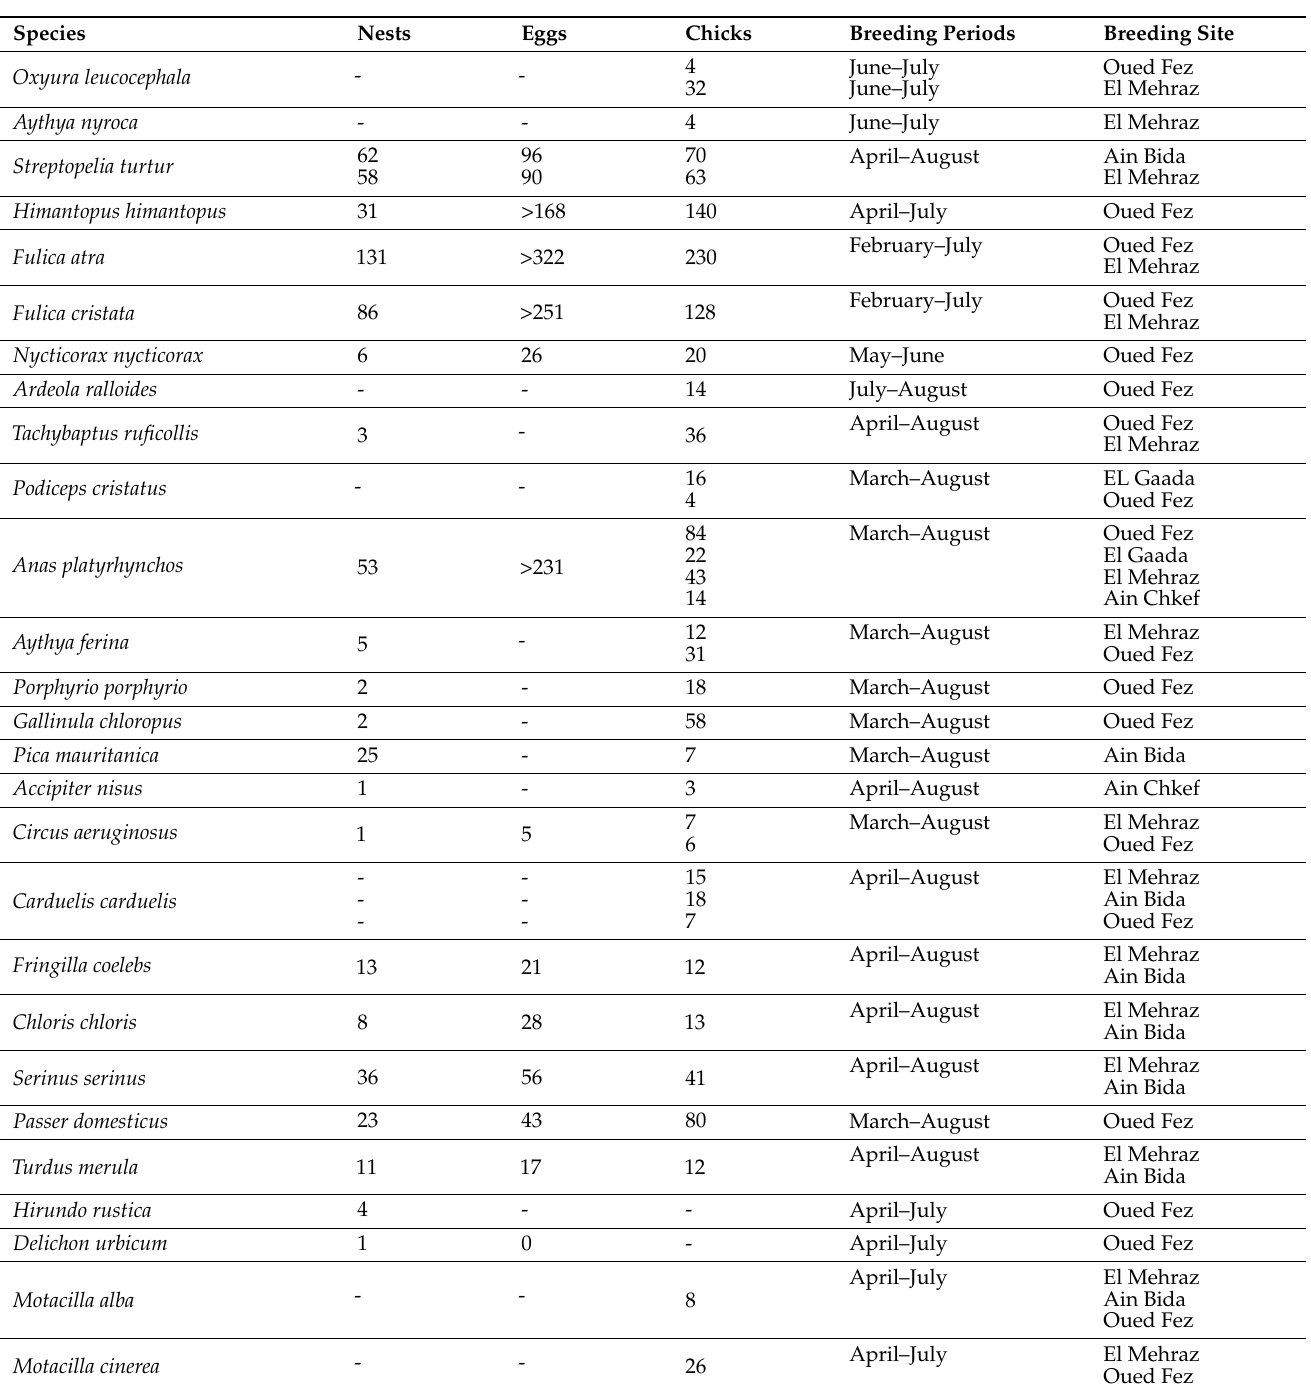
Table 3. Breeding populations of avian species recorded in Fez peri-urban area between 2018 and